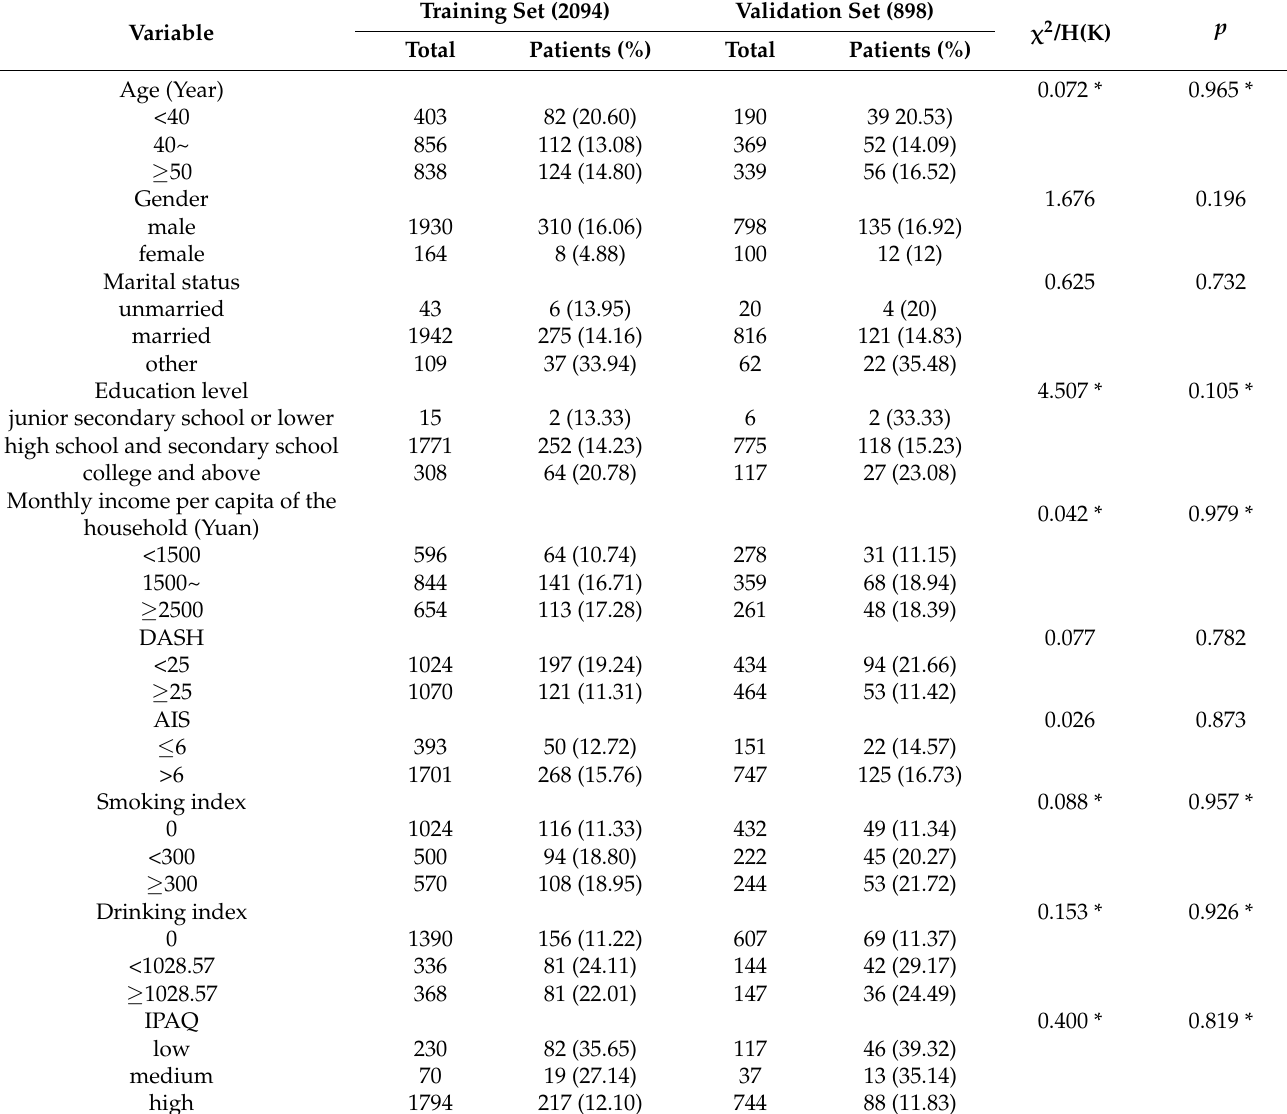
Table 1. Characteristics analysis of steelworkers.